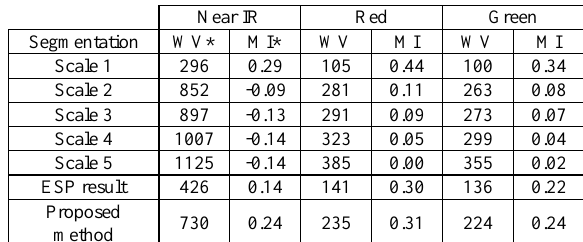
Table 2. Weighted variance and Moran’s index